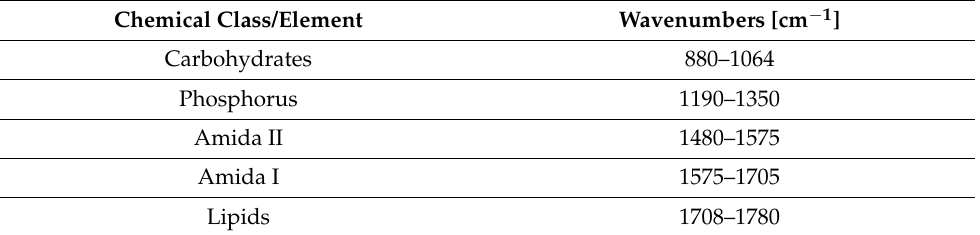
Table 2. Wavenumber ranges for classes of chemical compounds (according to [83],